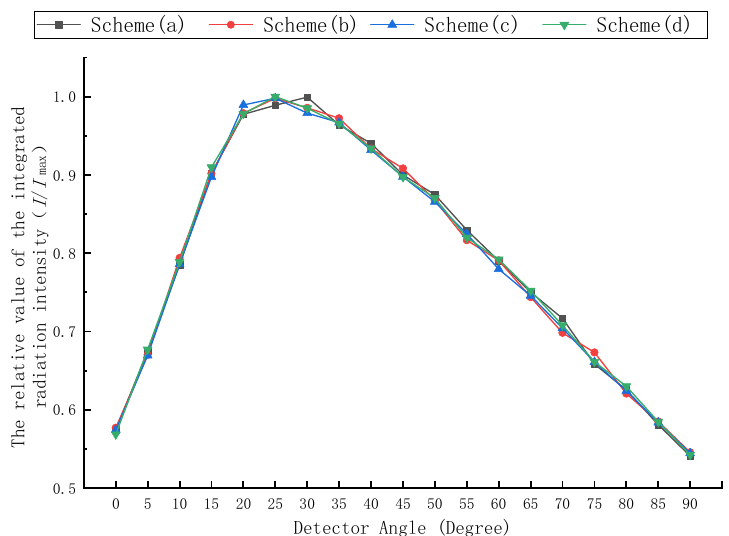
Figure 20. Radiation intensity curves of 80% damaged adjusting plates at different positions. Finally, the influence of the number of damaged adjusting plates on the overall in- frared radiation intensity of the coating was studied. The calculation results are presented in Figure 21.